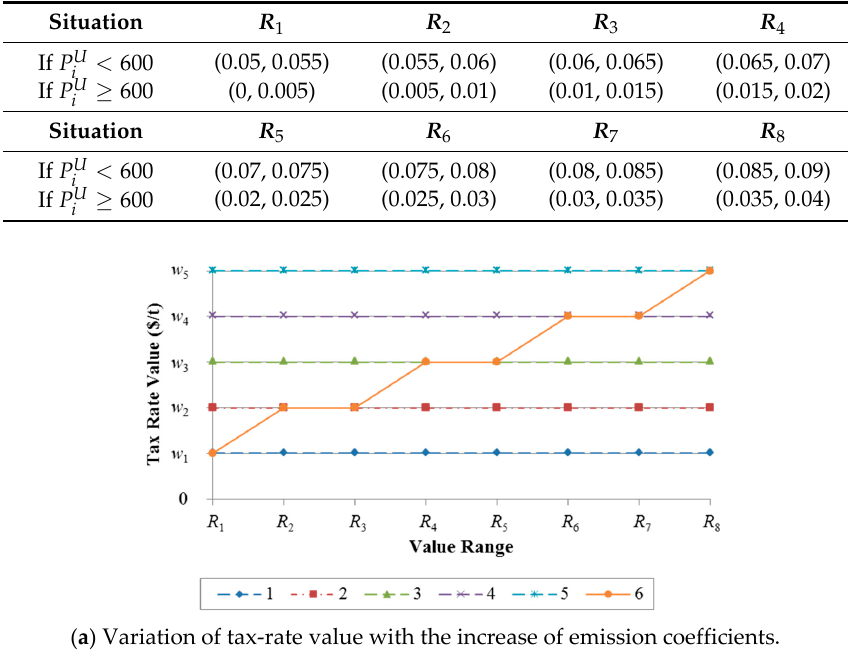
Table 6. Value ranges for emission coefficients.